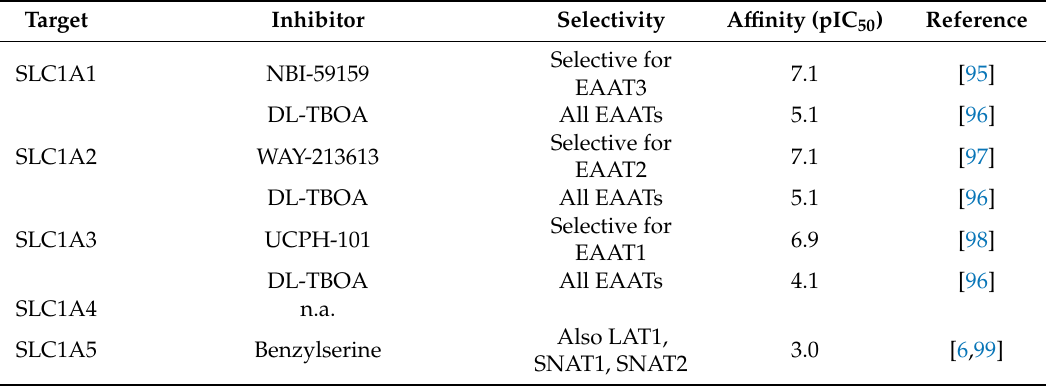
Table 3. Selectivity and a ffi nity of amino acid transporter inhibitors. Selectivity is listed against other amino acid transporters where tested. A ( + ) sign indicates that the compound has significant nontransporter targets where known. N.d. not determined; n.a. not